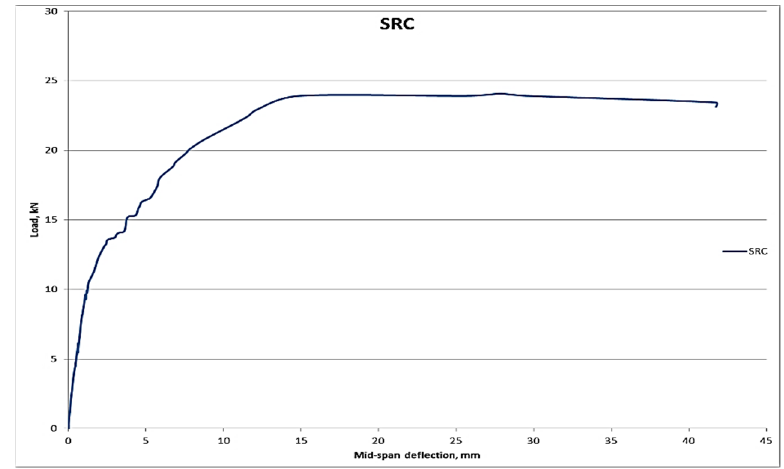
Figure 14. Mid-span load-deflection of the SRC beam.